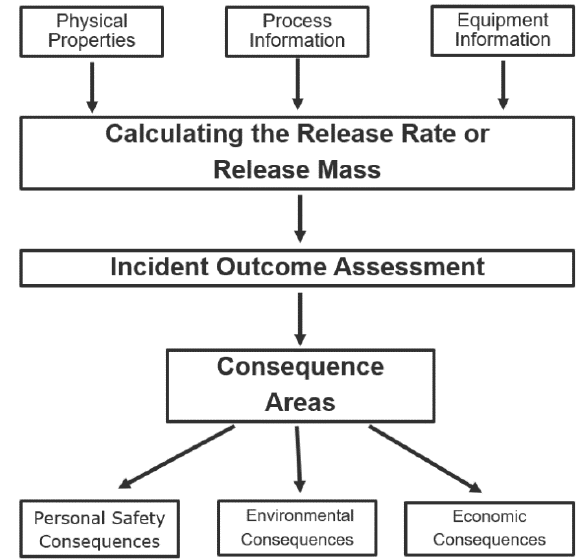
Figure 1. The Consequence of Failure ( CoF ) calculations based on API 581.